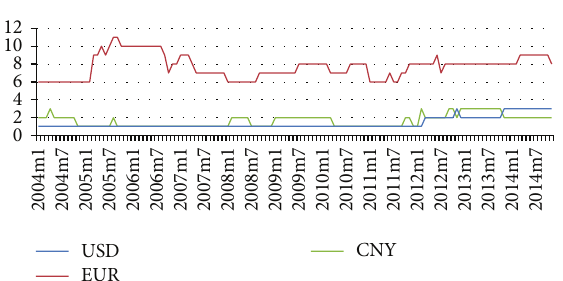
Figure 11: The number of links with respect to USD, EUR, and CNY (window length = 120 months).